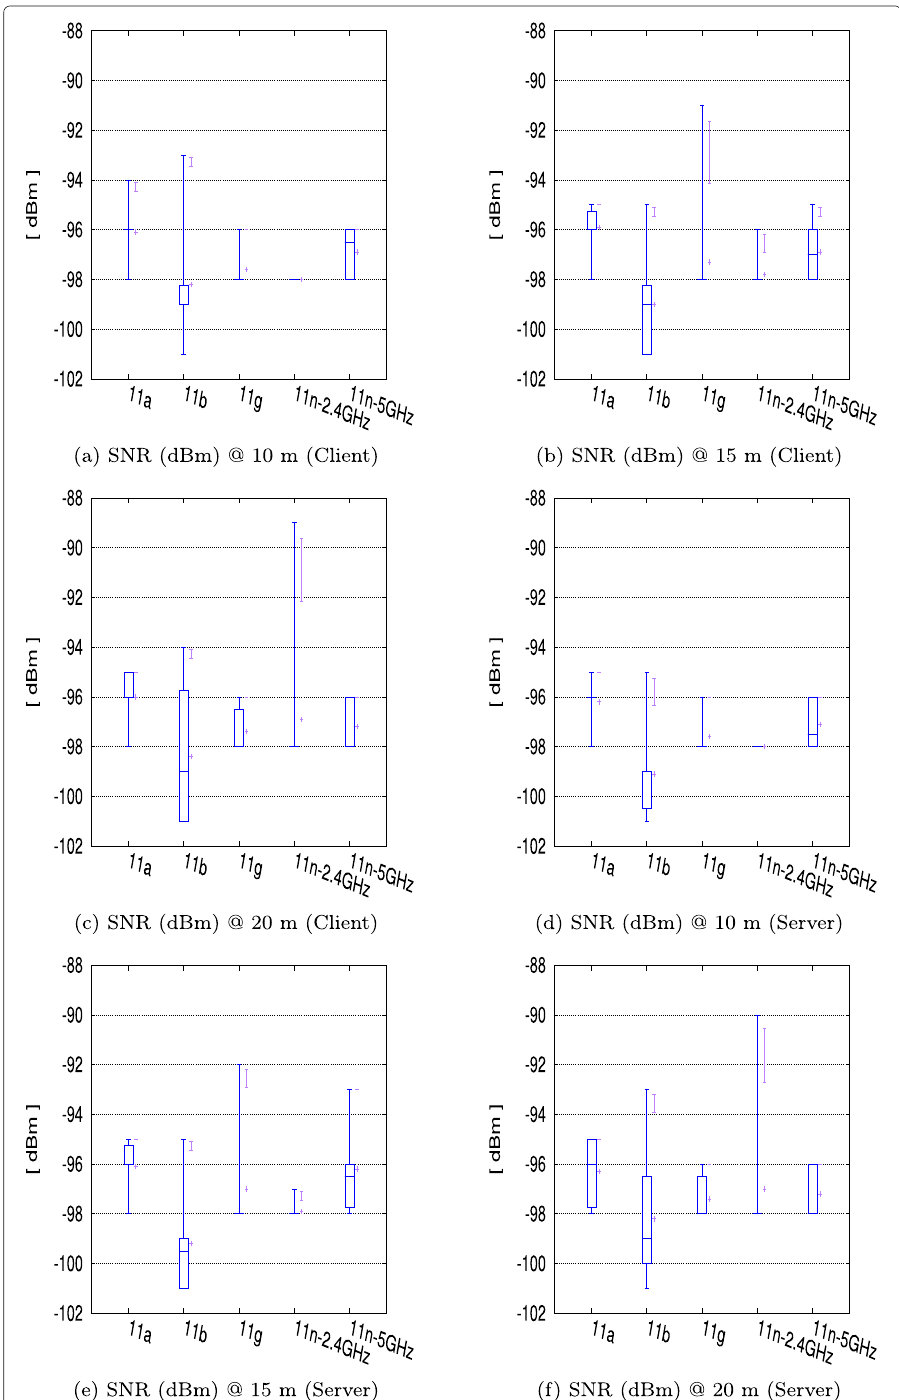
Fig. 4 SNR of 802.11 standards @ 10, 15, and 20 m for both client and server